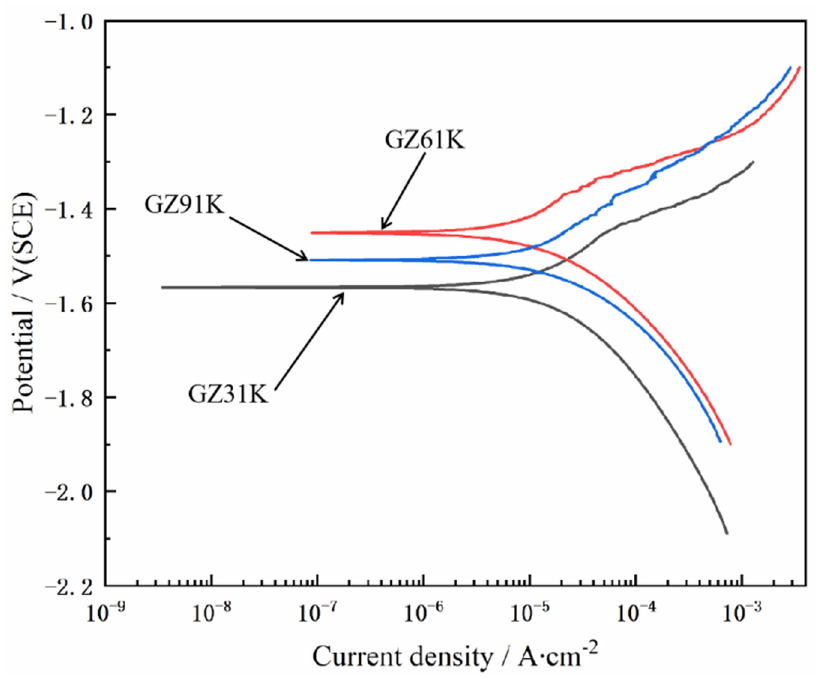
Table 3. Electrochemical parameters of the samples fitted from Figure 4. Alloys